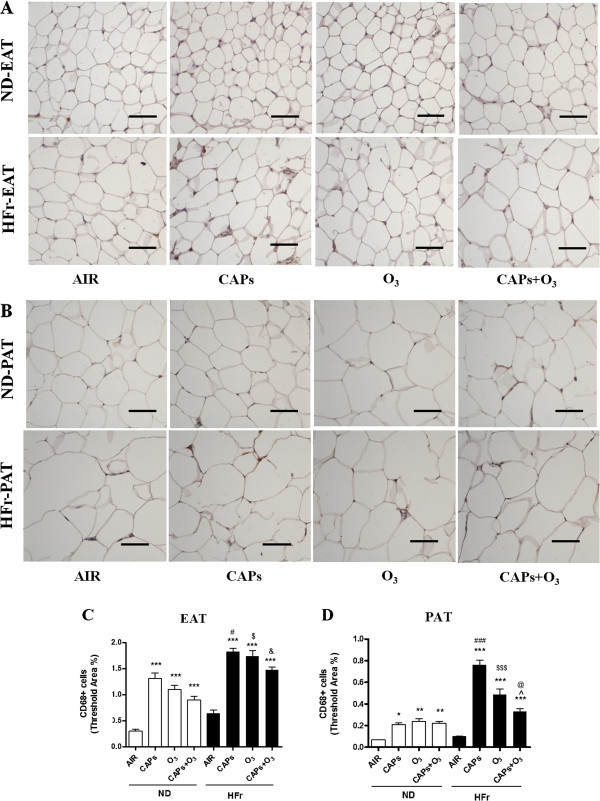
Macrophage infiltration in response to CAPs and O3 exposures in EAT and PAT. A and B, Representative images of immunohistochemical staining for CD68 in EAT (A) and PAT (B). C and D, Threshold area analyses of macrophages in EAT (C) and PAT (D). *p < 0.05,**p < 0.01, ***p < 0.001 vs. ND-AIR; #p < 0.05, ###p < 0.001 vs. ND-CAPs; $p < 0.05, $$$p < 0.001 vs. ND-O3;&p < 0.05 vs. ND-CAPs + O3; @p < 0.05 vs. HFr-CAPs, ^p < 0.05 vs. HFr -O3. Scale bars represent 100 μm. N = 7–8.